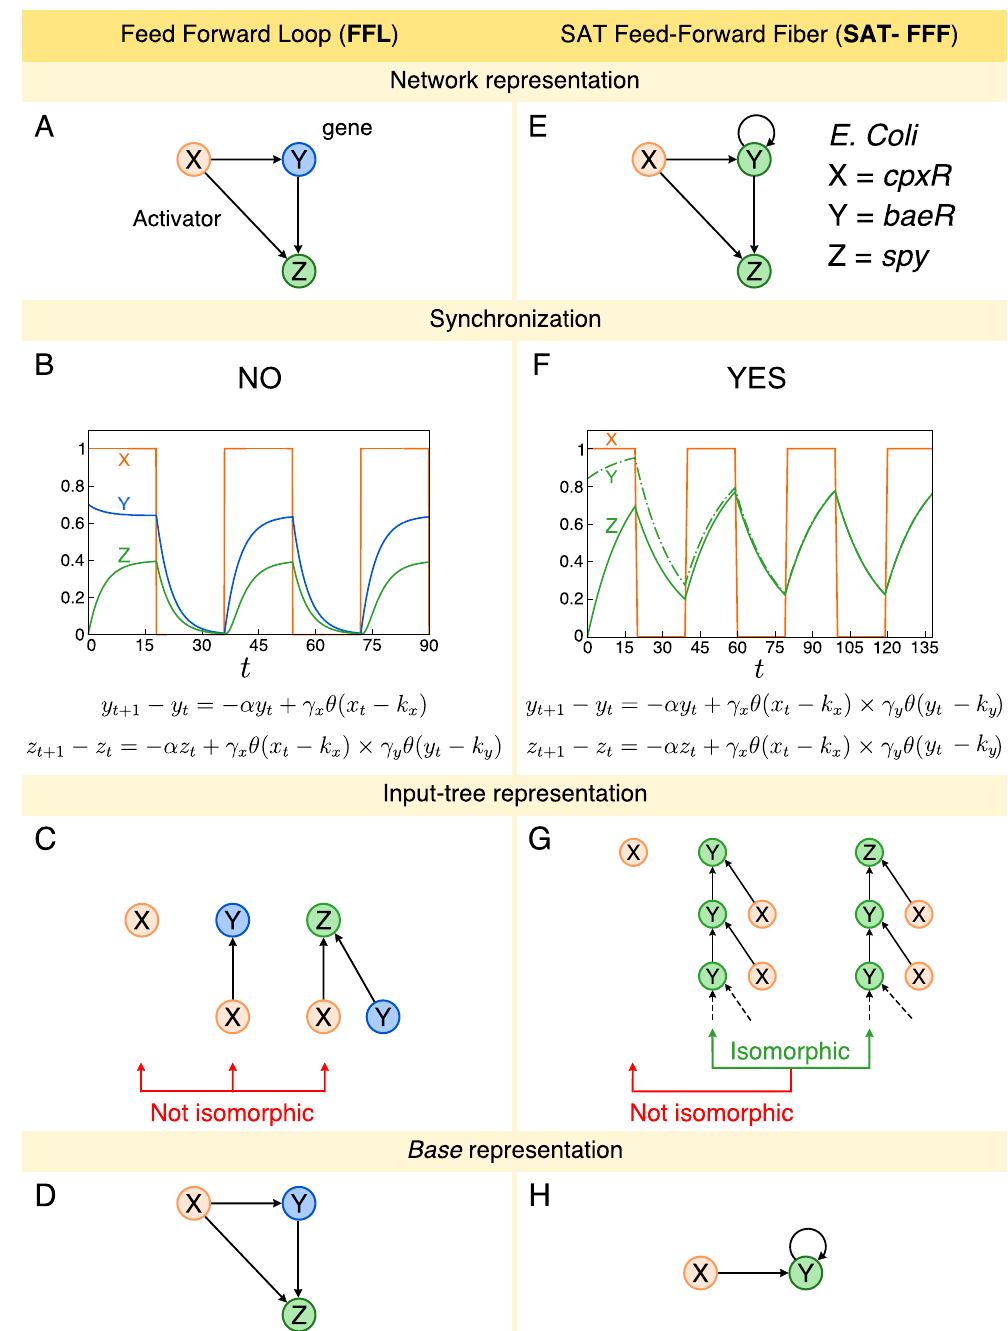
Fig 1. Feed-Forward Loop (FFL) and Feed-Forward Fiber (FFF). A: FFL network representation. B: Numerical solution of FFL dynamics. The expression levels of genes Y and Z do not synchronize. The oscillation pattern presented is due to the square-wave behavior of gene X expression levels. We use α = 2.0, γ = 0.12, γ = 0.7, k = 0.5, k = 0.1, y 0 = 0.7 and z 0 = 0.0. x y x y C: Input tree representation of FFL. The input trees of genes X, Y, and Z are not isomorphic, as a consequence, their expression levels do not synchronize. D: Base representation of FFL. The base is the same as the original circuits since there are no symmetries. E: SAT-FFF network representation. As an example, we consider genes cpxR = X, baeR = Y, and spy = Z from the gene regulatory network of E. coli . The addition of the autoregulation leads to a symmetry between the expression levels of genes Y and Z. F: The numerical solution of the SAT-FFF dynamics shows the synchronization of the expression levels of genes Y and Z. We use α = 0.06, γ x = 0.775, γ y = 0.775, k x = 0.5, k y = 0.1, y 0 = 0.85 and z 0 = 0.0. Again, the oscillation is due to the wave-like pattern of X. G: As a result, genes Y and Z have isomorphic input trees. However, the input tree of